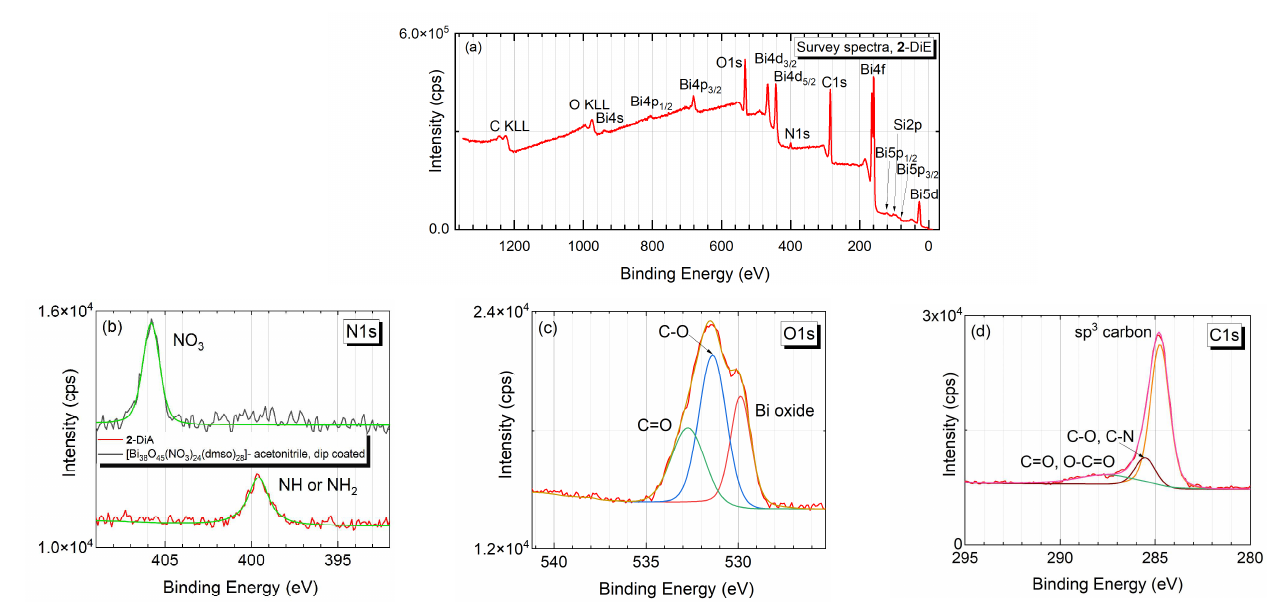
Figure 2. ( a ) Survey X-ray photoemission spectra of 2- DiA; high resolution spectra for ( b ) N 1s comparison between 2- DiA and A ; a clear indication of successful ligand exchange is provided by the shift to lower binding energies of ( c ) O 1s and ( d ) C 1s core levels.